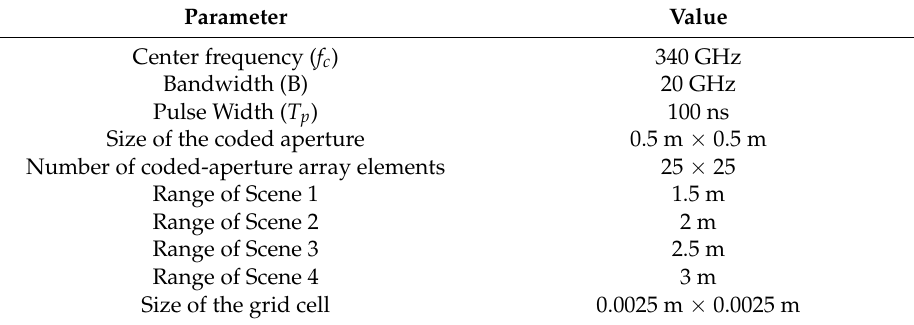
Table 4. Primary parameters used in the experiments.